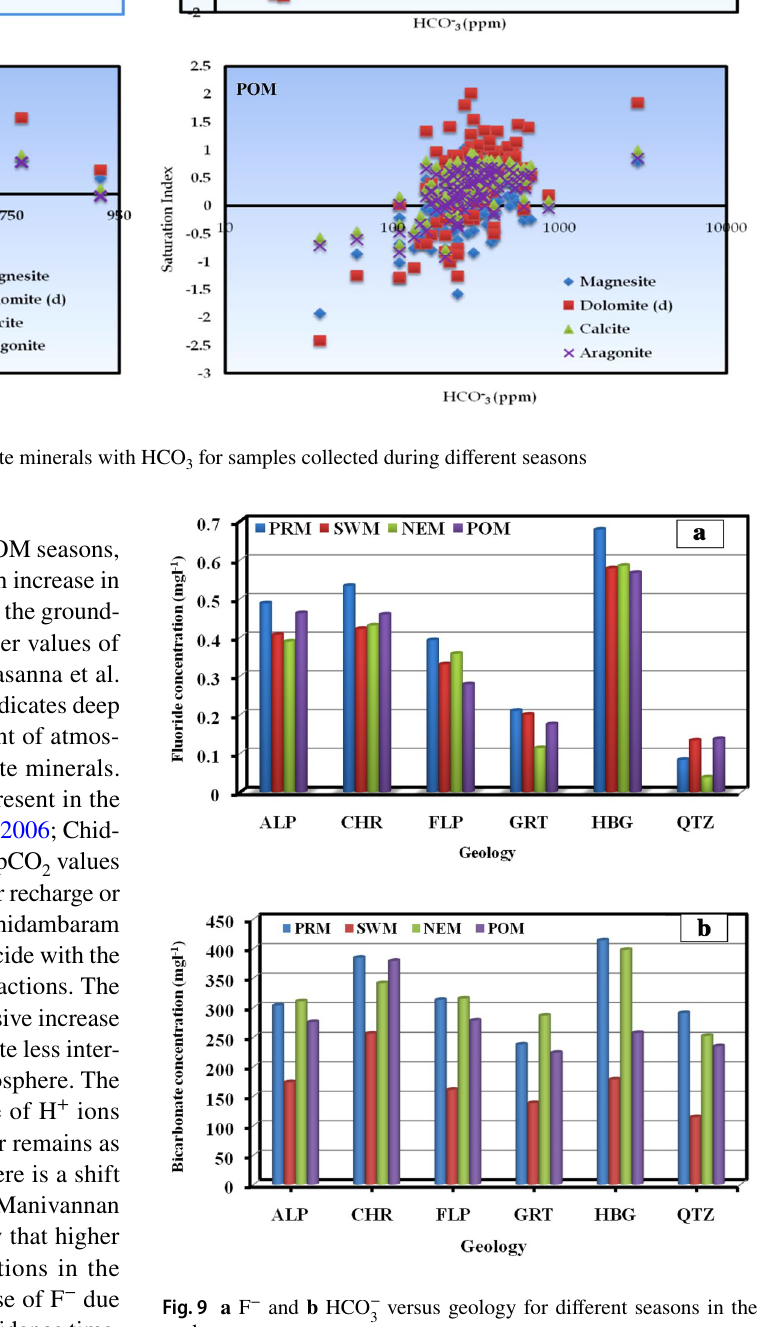
Fig. 9 a F − and b HCO − 3 versus geology for different seasons in the study